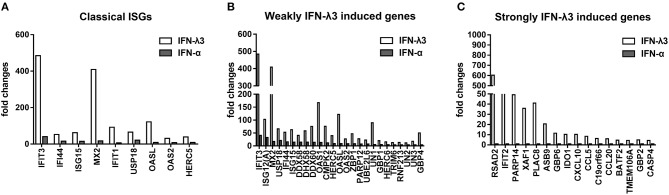
Graphical representation showing the fold change analysis of different gene subgroups [“classical antiviral IFN-stimulated genes (ISGs),” “weakly IFN-λ3-induced genes,” and “strongly IFN-λ3-induced genes”]. (A) The classical antiviral IFN-stimulated gene (ISG) subgroup. “Classical ISGs” were defined by their designation in the literature. (B) The weakly IFN-λ3-induced gene subgroup. “Weakly IFN-λ3-induced genes:” fold increase by IFN-λ3 over mock control/fold increase by IFN-α over mock control >2 and fold increase by IFN-α over mock control >4. Unknown genes were named as UN1, UN2, and UN3. (C) The strongly IFN-λ3-induced gene subgroup. “Strongly IFN-λ3-induced genes:” fold increase by IFN-λ3 over mock control/fold increase by IFN-α over mock control >4 and fold increase by IFN-α over mock control <2.